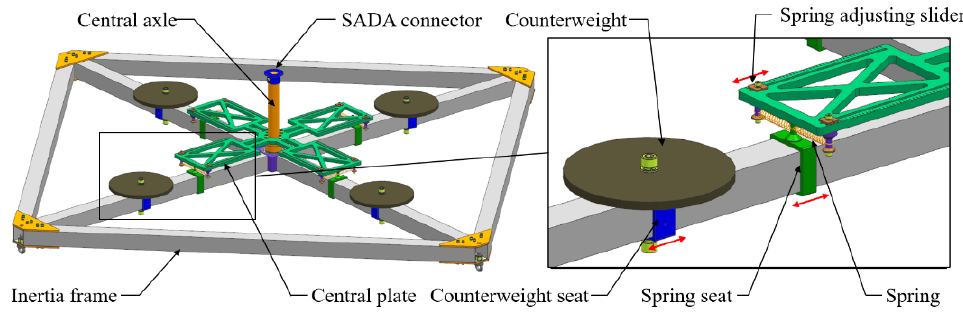
Figure 7. A structure model of the SAS.